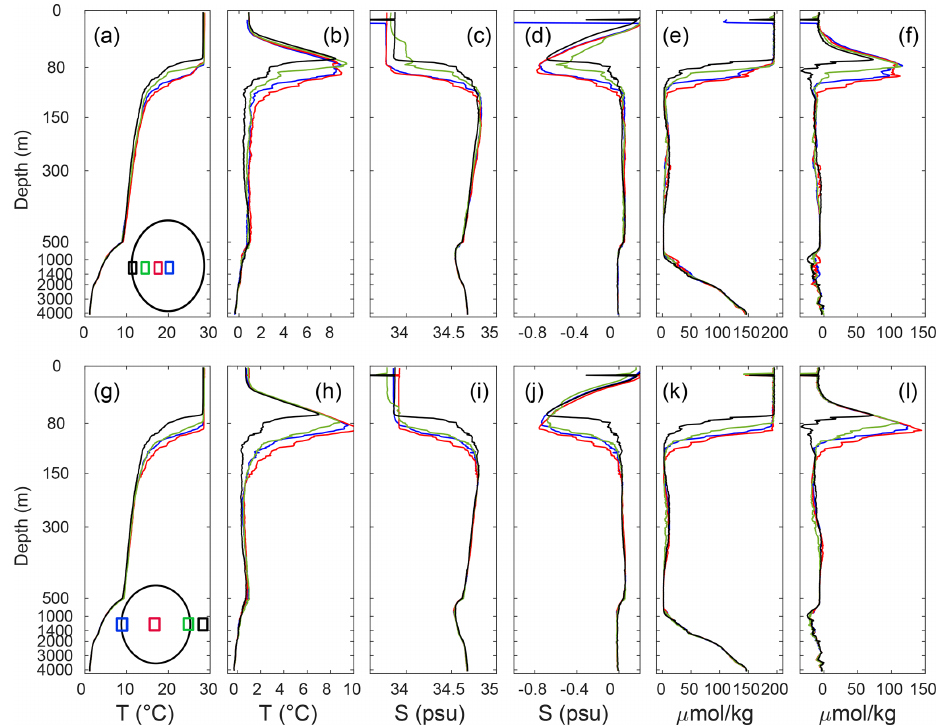
Figure 6. Vertical profiles of (a) temperature, (c) salinity, and (e) dissolved oxygen concentration and of anomalies in the parameters at (b) , (d) , and (f) respectively. The top panels show each parameter and its anomaly on an east–west transect between 2 and 4 April. The relative position of the CTD casts with respect to the eddy is shown in (a) and (g) . Panels (g) , (i) , and (k) show vertical profiles of temperature, salinity, and dissolved oxygen in replicate CTD casts at the same position between 4 April and 16 May. Associated anomalies of temperature, salinity, and dissolved oxygen are shown in (h) , (j) , and (l) , respectively. For a better focus on upper ocean layers, a non-equivalent vertical y axis is applied in this figure. Every anomaly is calculated with reference to the corresponding profile of